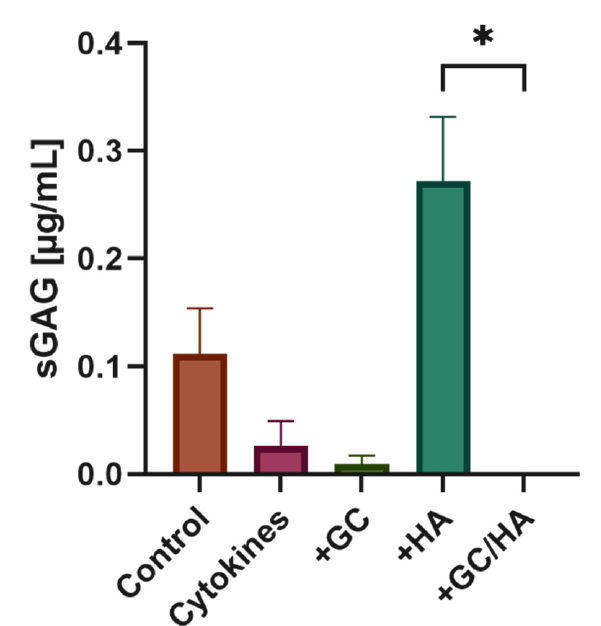
Figure 8. Concentration of sulfated glycosaminoglycans in the culture medium on Day 6 after adding 10% of test substances to cytokine-treated chondrocytes. The single asterisk indicates p < 0.05.